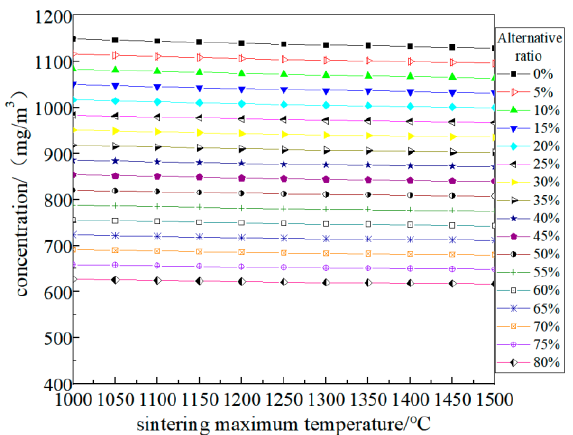
Figure 9. Change of NO X emission concentration in the case of straw charcoal substitution.